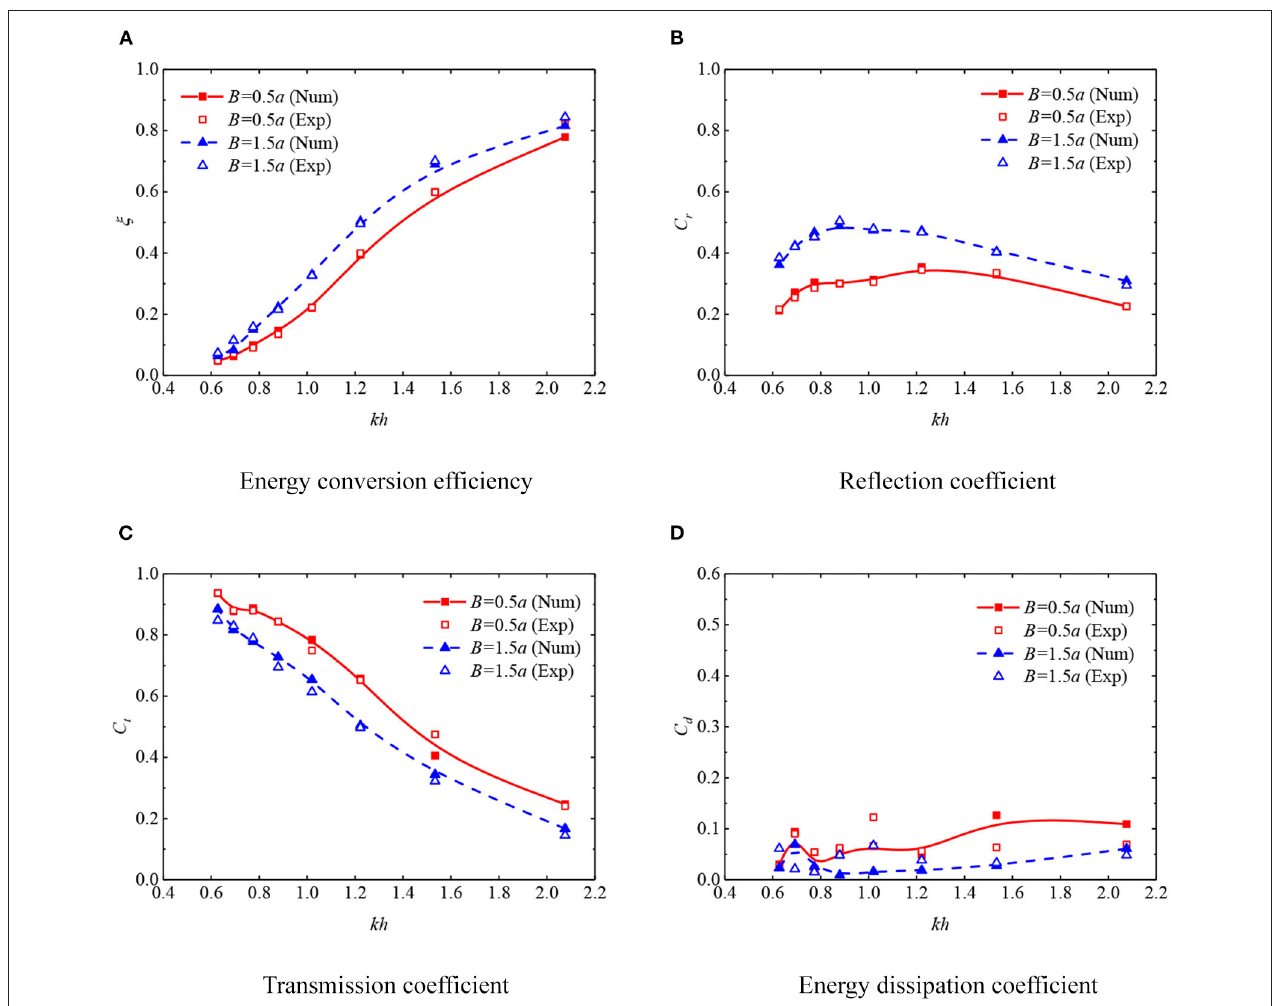
FIGURE 6 | Comparisons of the experimental and numerical results. In all cases, a = 0.2 m, H i = 0.03 m, and d 2 = 0.2 m. (A) Energy conversion efficiency. (B) Reflection coefficient. (C) Transmission coefficient. (D) Energy dissipation coefficient.